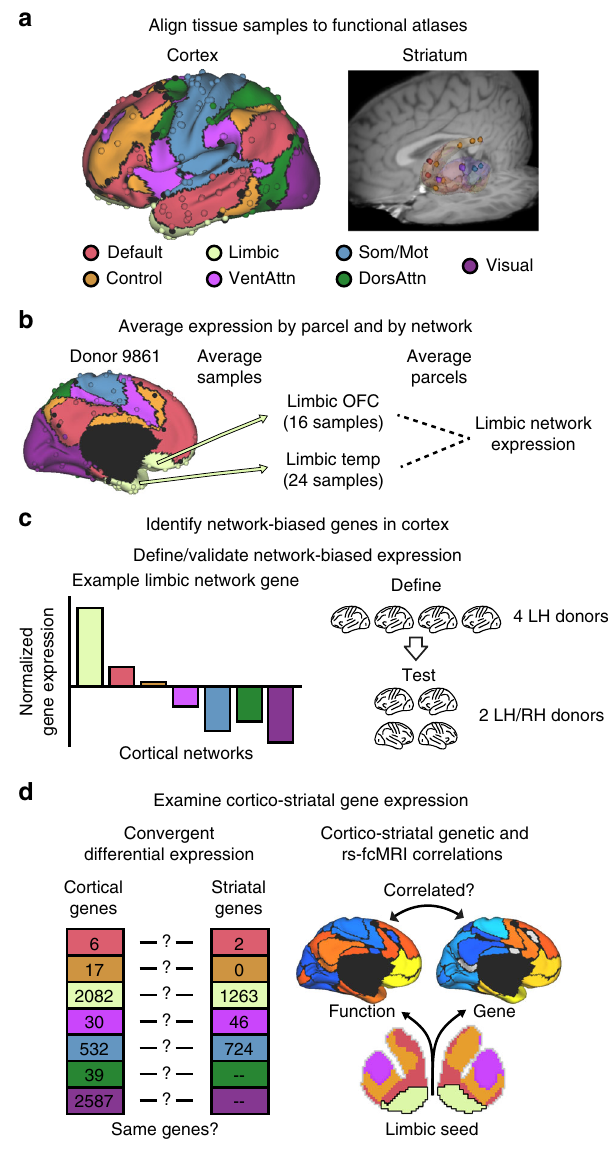
Fig. 1 Characterizing the correspondence between cortico-striatal functional architecture and gene expression. a Individual tissue samples from the Allen Human Brain Atlas were aligned to the cortical functional connectivity atlas of Yeo et al. 36 and the striatal atlas of Choi et al. 9 . Samples were grouped into default, frontoparietal control, limbic, ventral attention, somato/motor, dorsal attention, and visual networks. b For each individual donor, gene expression was averaged according to functional parcel, then by overall network, resulting in a single expression vector for each network in each donor. c Differential expression analyses revealed genes with biased expression across cortical networks. For instance, genes expressed most in tissue samples falling within limbic (cream) network regions relative to all others. Network-biased genes were initially identi fi ed in cortex of the four left hemisphere donors and cortico-cortical correlations were examined in the two bi-hemispheric donors. d Network- biased genes were re-de fi ned in the cortex of all six available AHBA donors and were cross-referenced to network-biased genes in the corresponding region of the striatum. The genetic and resting-state functional correlation between each striatal sub-region and each cortical parcel is then calculated and